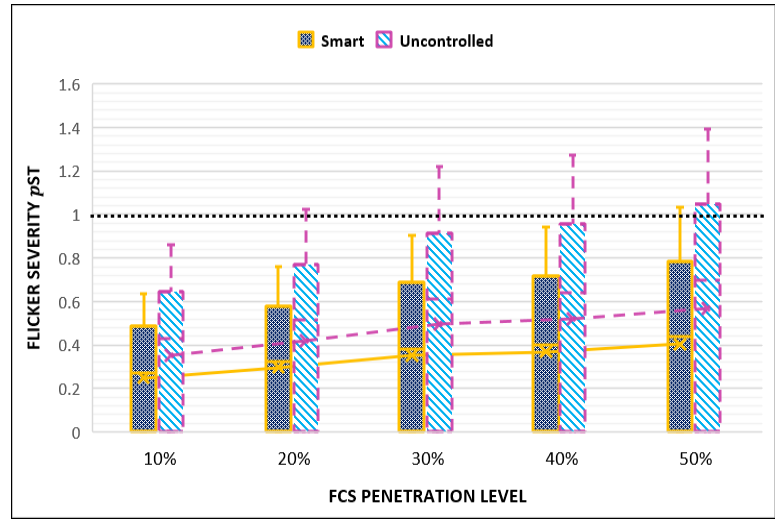
Figure 15. Comparison of flicker level for uncontrolled and proposed smart charging.